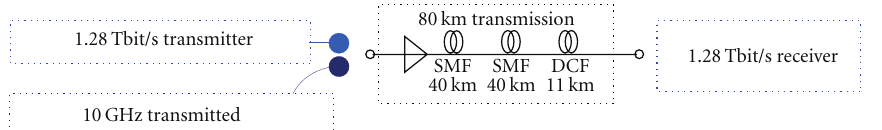
Figure 8: Transmission set-up. A transmitted 10GHz clock signal are used for synchronizing the receiver. 80km SMF and 11km DCF is used.